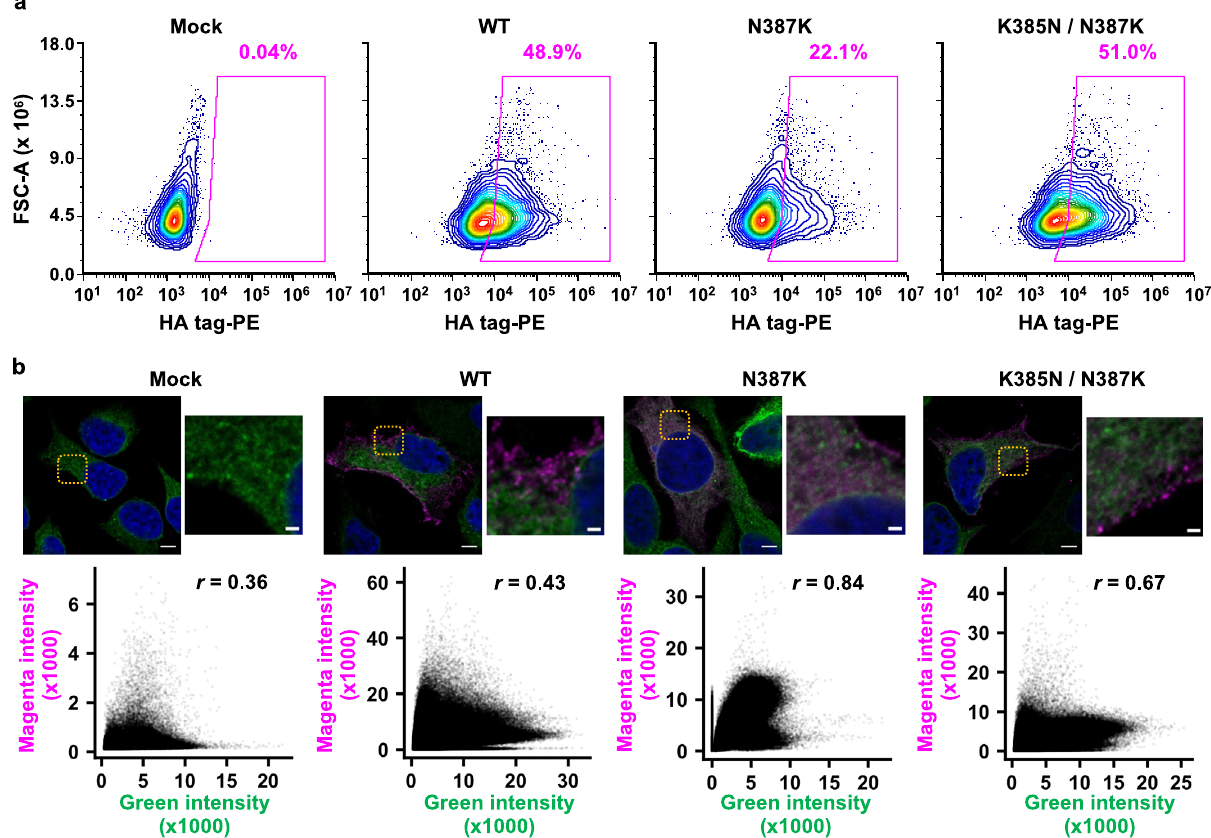
Fig. 5 | Cell surface protein expression and intracellular localization of NA Mos99 mutants. a Cell surface expression of HA-tagged Mos99 mutants was analyzed by fl ow cytometry. b Confocal microscopy result of HA-tagged Mos99 mutants. Blue (DAPI), Green (Calnexin, ER), Magenta (NA). The orange box high- lightsthezoomedinregion.Scalebarforthelargeimageis5 µ mandforzoomedin